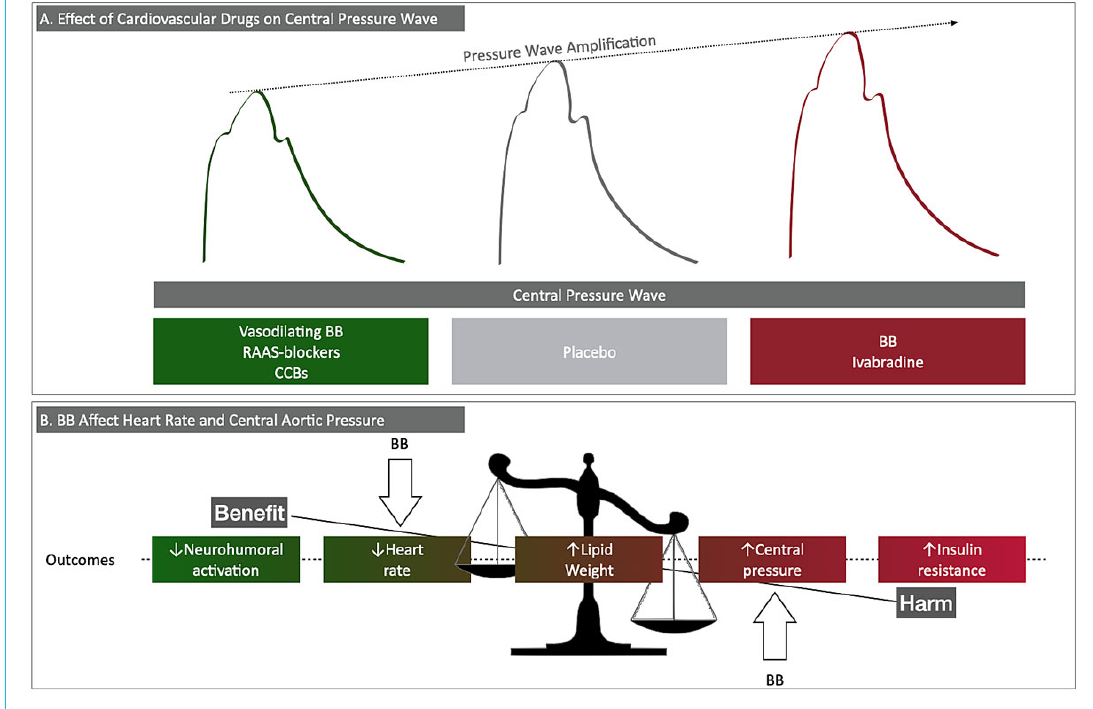
Figure 1: Panel A . Effect of cardiovascular drugs on central pressure wave. Lowering of resting heart rate increases central pressure (com- pared with placebo). Panel B. Duality of beta-blocker therapy in STEMI patients. Beta-blockers may affect clinical outcome on one hand